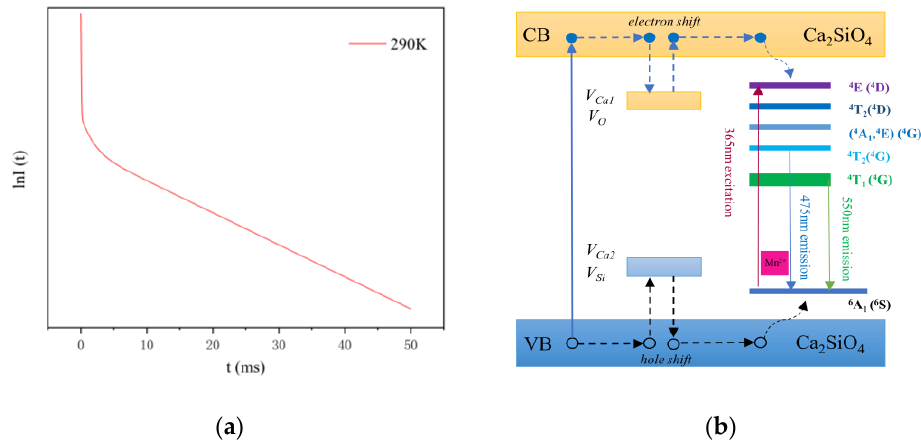
Figure 4. ( a ) The fluorescence intensity decay curve of CSO:Mn 2+ . ( b ) Energy-level diagram and the long persistent fluorescence mechanism of CSO:Mn 2+ .